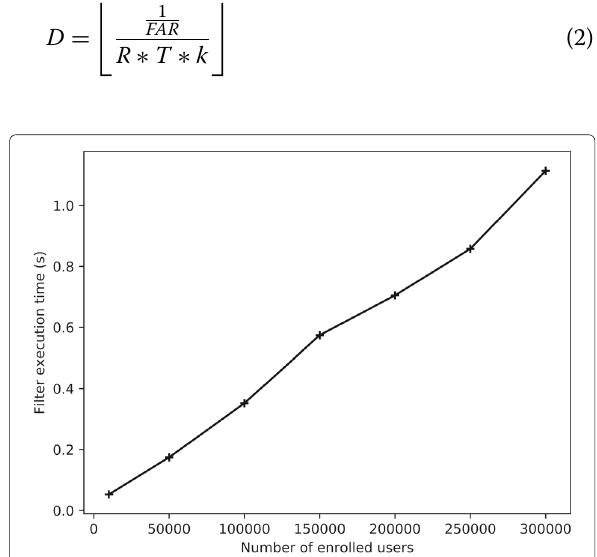
Fig. 11 Average computation time of the improved